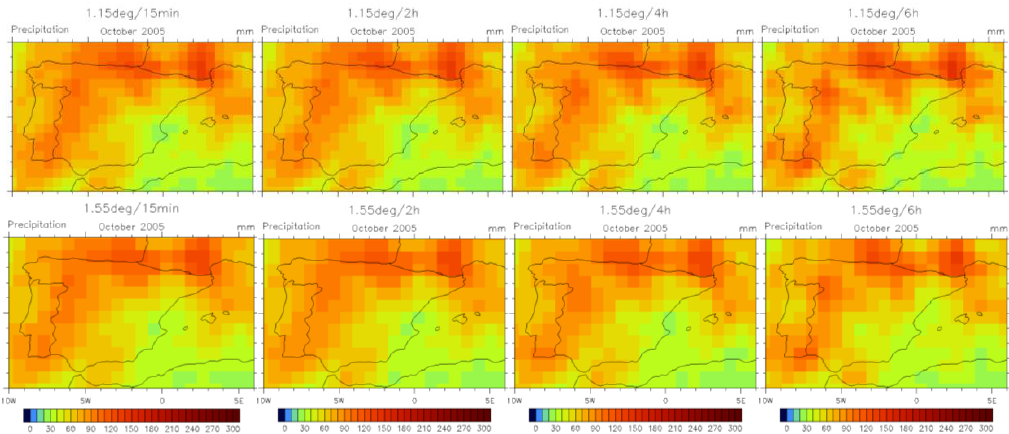
Figure 4. An example of monthly-aggregated precipitation simulations at several spatial resolution and time sampling for the October 2005 case study. The 0.05°/15- min estimate is the reference ‘truth’.